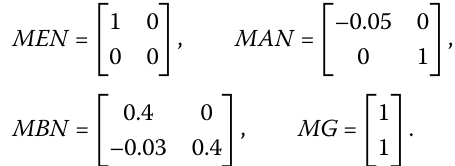
A )) = rank ( E ) = 1. Thus, system (2.1) is regular and causal. For nonsingular matrices M =